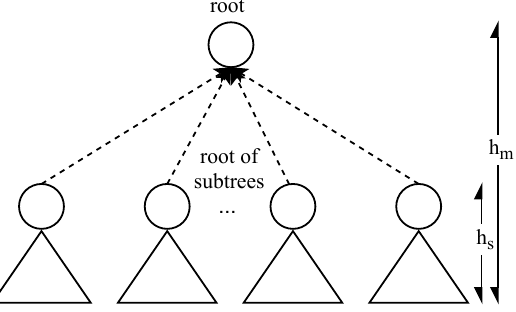
Figure 3. The tree of height 2 h m is split into 2 h m − h s subtrees of height 2 h s .